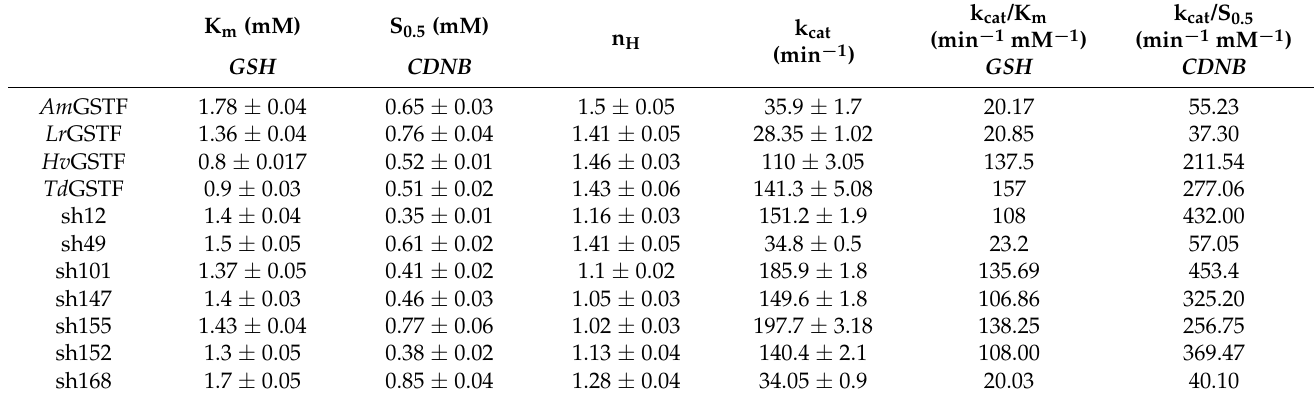
Table 1. Steady-state kinetic parameters of wild-type GSTFs and enzyme variants for the CDNB/GSH substrate system. Kinetic analysis was performed at 37 ◦ C and pH 6.5. The measurements were performed in triplicate and the data represent the mean ± SD (N = 3). The parameters k cat /K m and k cat /S 0.5 were calculated by the established mean